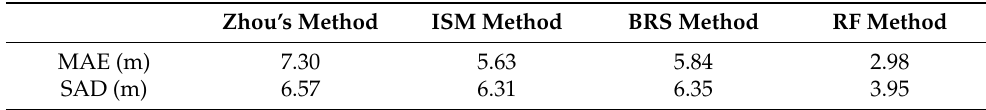
Table 2. MAE and SAD values of the four extraction